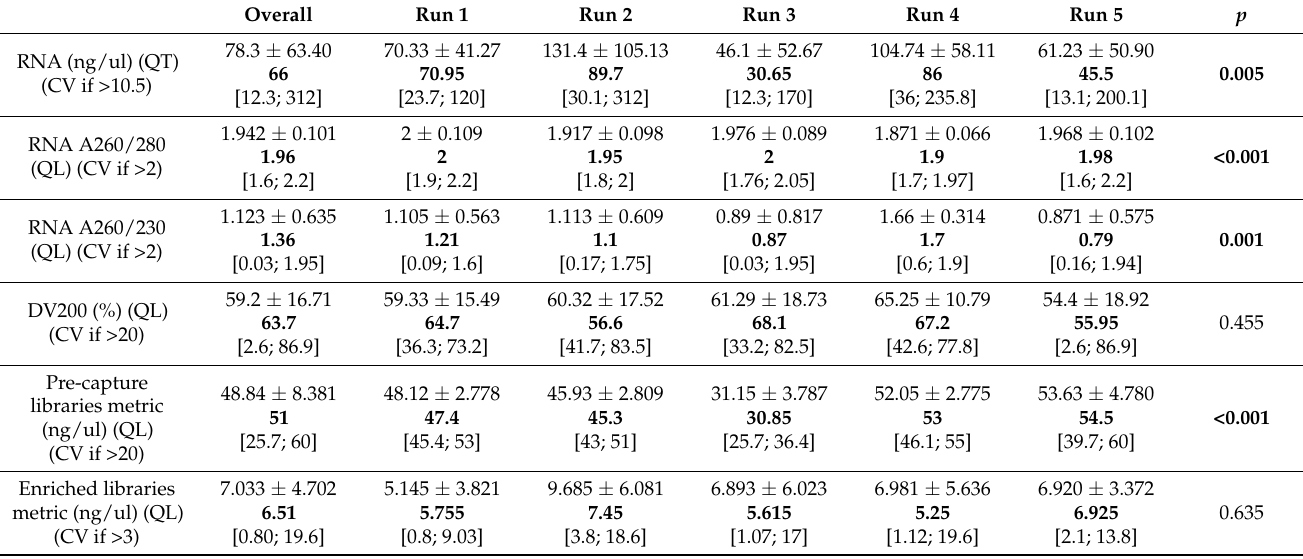
Table 2. RNA wet quality metrics. Quality metrics values, for each run, are reported as mean ± stan- dard deviation and median [range] of the 59 RNA samples. A Kruskal–Wallis test is used to evaluate the null hypothesis of the equality of the medians among the runs. Median values are reported in bold. p -values ( p ) below 0.05 are considered